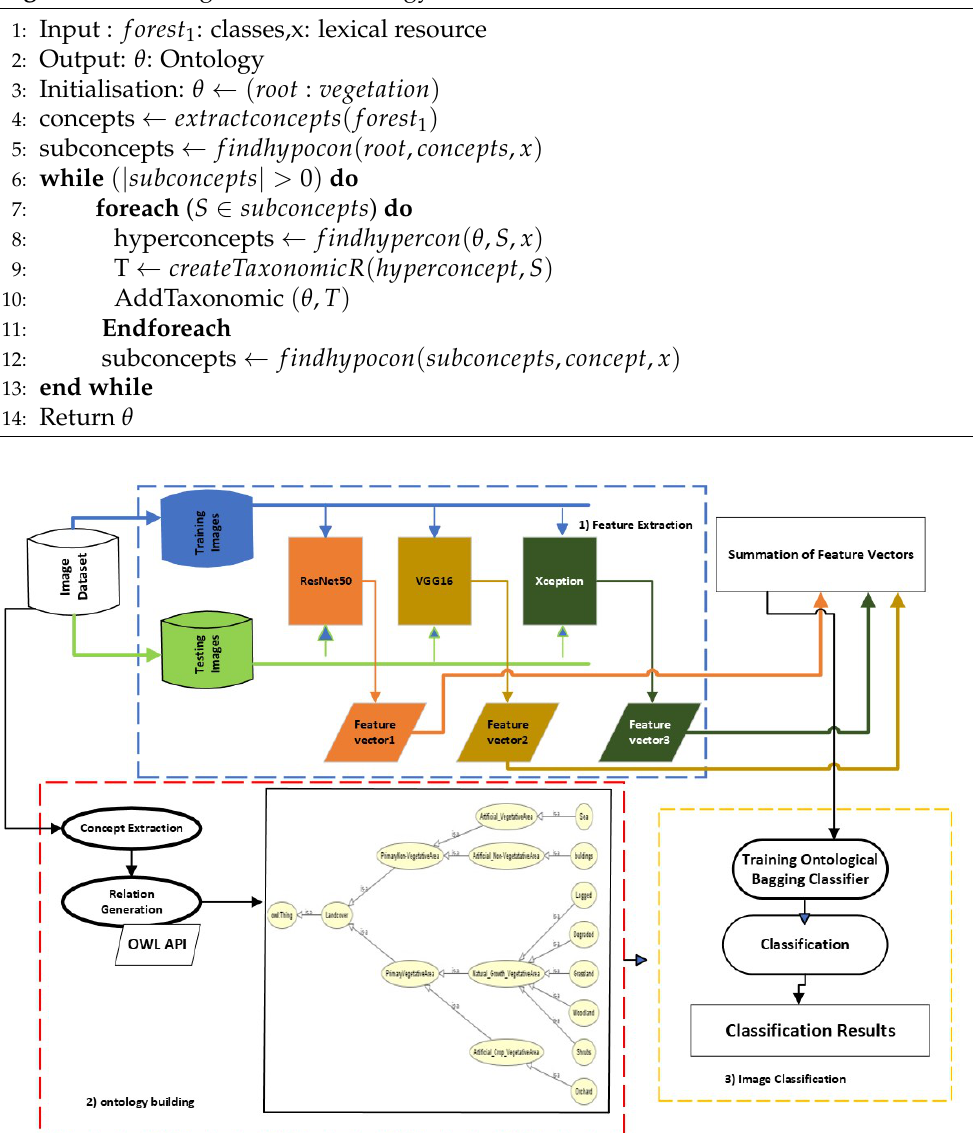
Algorithm 1 An algorithm for ontology construction